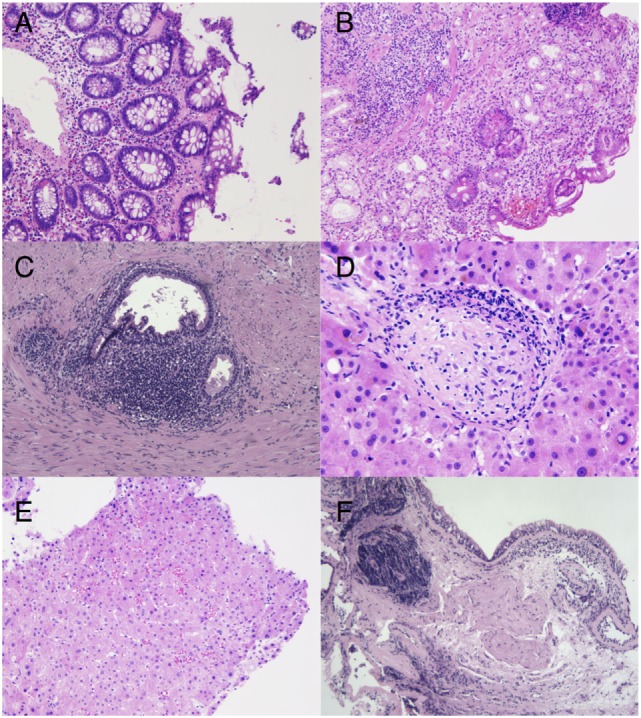
(A) Hematoxylin and eosin stain. Colon biopsy showing irregular thickening of the subepithelial basement membrane, encircling some capillaries, indicating a collagenous colitis (original magnification, ×20). (B) Hematoxylin and eosin stain. Glandular atrophy in the gastric body with foci of intestinal metaplasia and deep lymphoplasmacytic infiltrates, suggestive of an autoimune gastritis (original magnification, ×20). (C) Hematoxylin and eosin stain. Reactive periglandular chronic inflammation in the prostate (original magnification, ×10). (D) Hematoxylin and eosin stain. Rare lobular non-necrotizing epithelioid granulomas with peripheral lymphoid ring are found in addition to unspecific portal inflammation (original magnification, ×40). (E) Hematoxylin and eosin staining of a liver biopsy showing mild sinusoidal distension in the liver biopsy (original magnification, ×20). (F) Hematoxylin and eosin stain. Bronchial wall containing lymphoplasmocytic aggregates of variable densities with crush artifacts (original magnification, ×10).